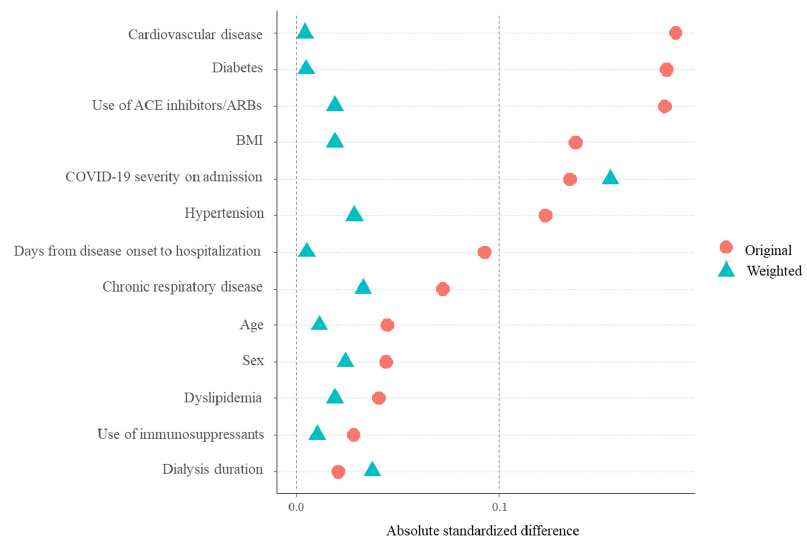
Figure 1. Percentage of patients without progression to severe COVID-19 stratified by vaccination status estimated by the Kaplan–Meier method. Abbreviations: COVID-19, coronavirus disease 2019.